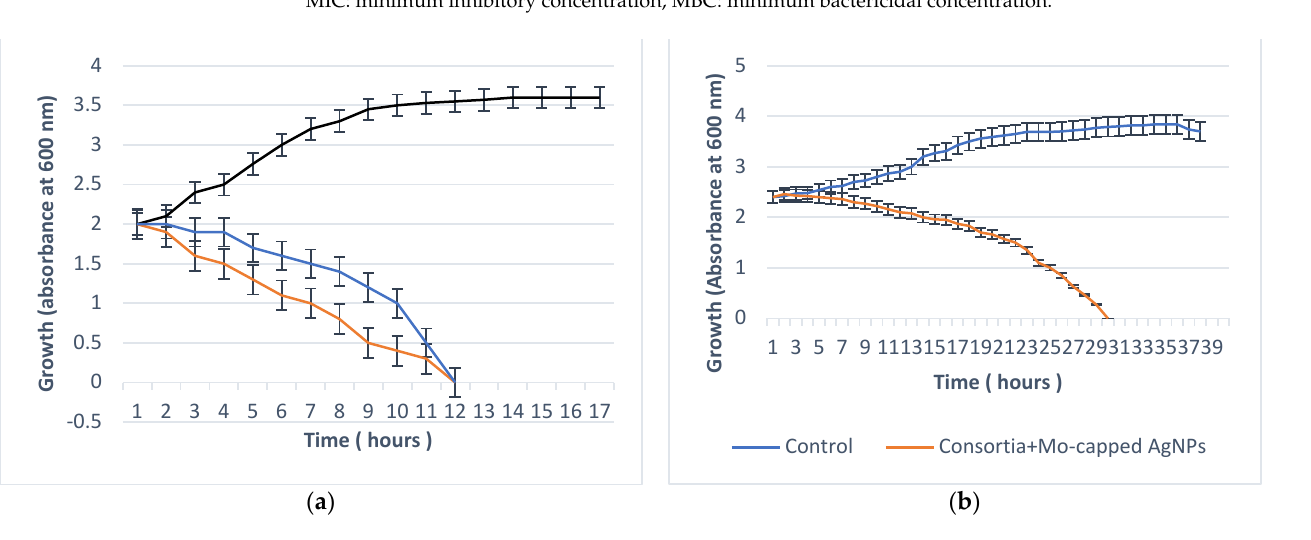
Figure 5. Microbial lethality curve against S. aureus ATCC 6538 (red line) and C. albicans DAY185 (blue line) ( a ) and consortia of both ( b ).